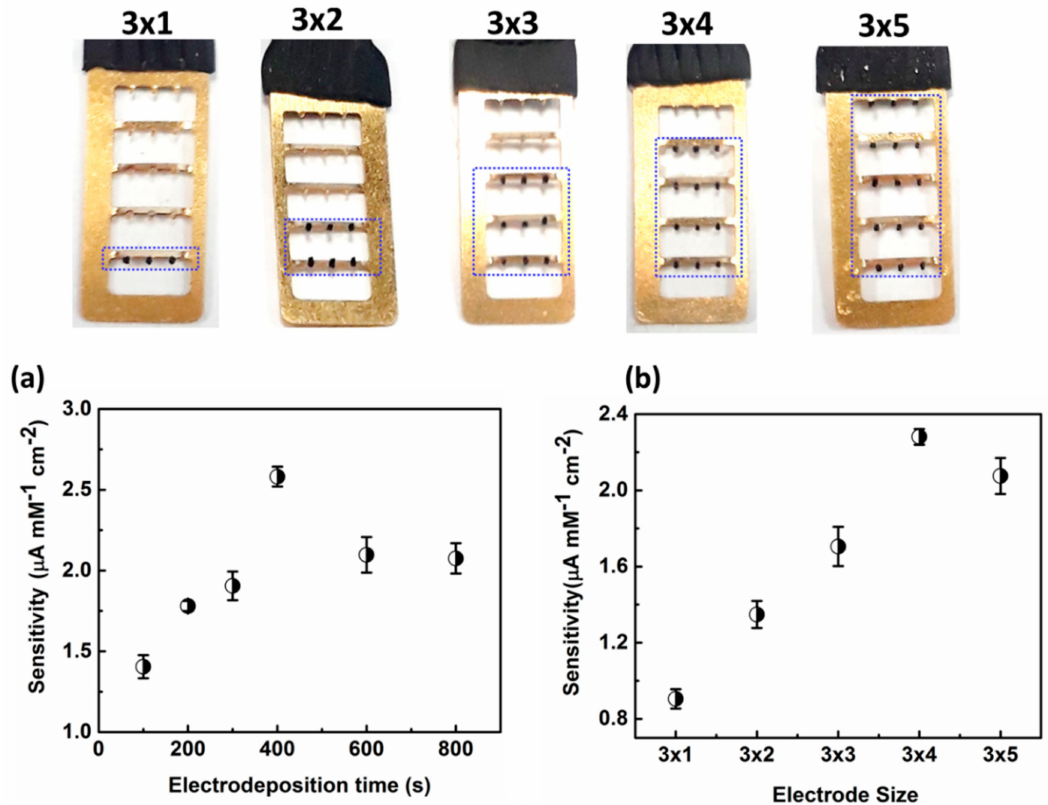
Figure 5. Effects of Pt-black electrodeposition time ( a ) and electrode array size ( b ) on the sensor response for continuous glucose monitoring